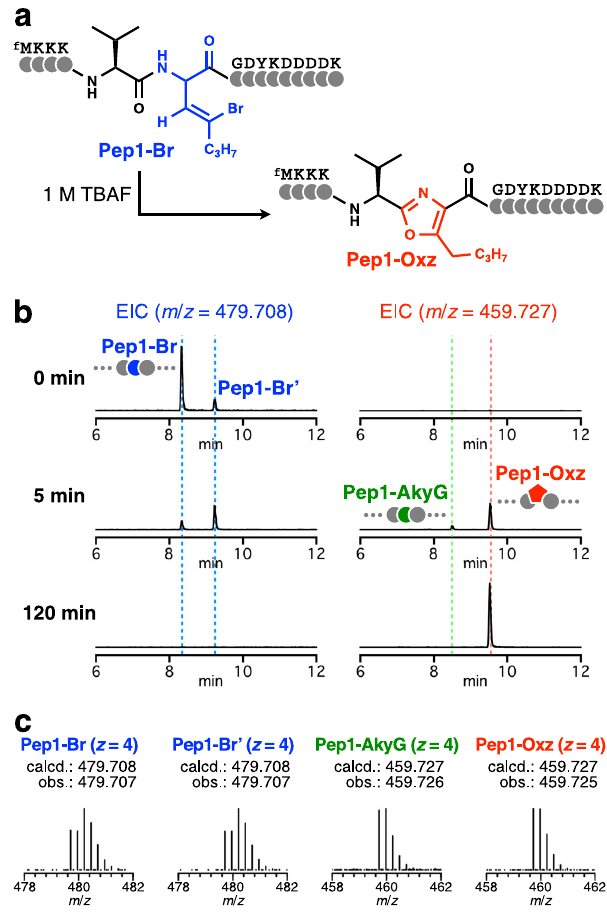
Fig. 2 Chemical posttranslational modi fi cation of a model peptide bearing BrvG to yield an oxazole-containing peptide. a Sequence of the model peptide Pep1-Br and its corresponding oxazole-containing peptide Pep1- Oxz. b LC-ESI-MS analysis to monitor the chemical posttranslational modi fi cation of Pep1-Br. The translated Pep1-Br was incubated with 1 M TBAF for 0, 5, and 120 min and analyzed by LC-ESI-MS. EICs with m / z values corresponding to the precursor (Pep1-Br/Pep1-Br', 479.708) and the expected dehydrobrominated product (Pep1-AkyG/Pep1-Oxz, 459.727) are shown. The peaks corresponding to Pep1-Br/Pep1-Br', Pep1-AkyG, and Pep1-Oxz are labeled with blue, green, and red dotted lines, respectively. Additional EICs of more time points are shown in Supplementary Fig.